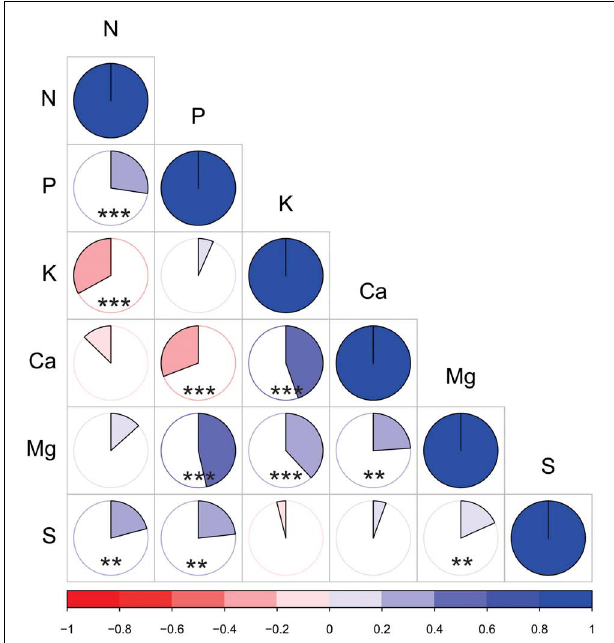
FIGURE 3 | Pearson correlation coefficient r values among grain nutrients (g 100 g − 1 ). Positive correlations are displayed in blue, and negative correlations are displayed in red. The color intensity and arc length of each slice are proportional to the correlation coefficients. **Significant at 0.01% and ***significant at <